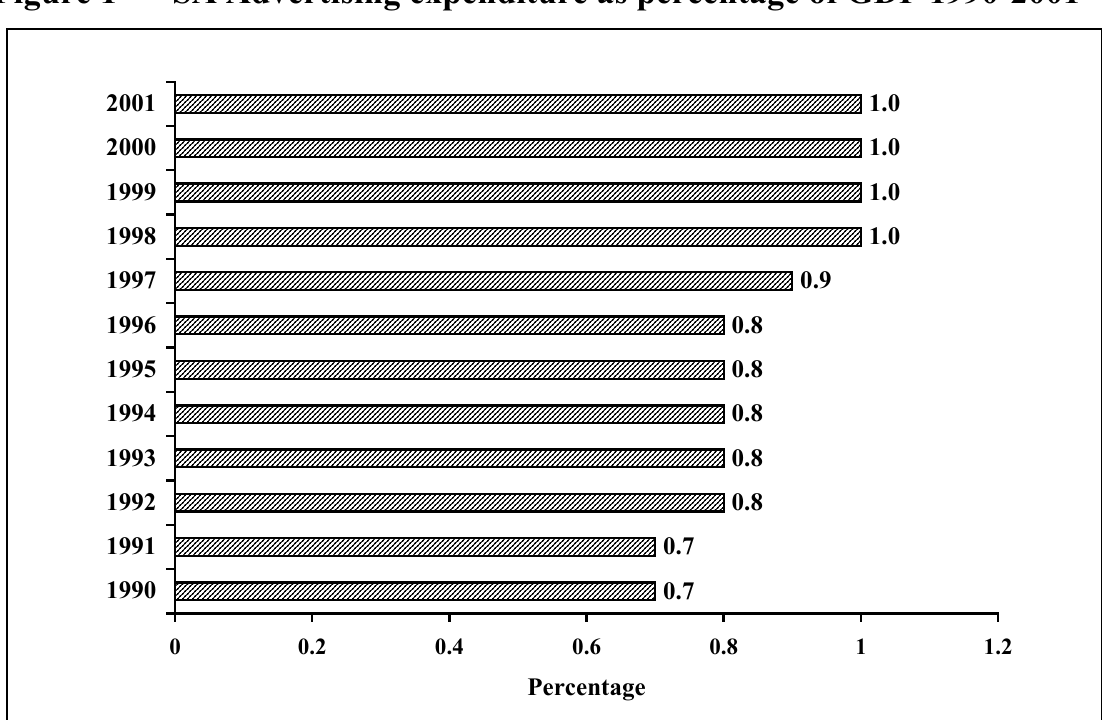
SA Advertising expenditure as percentage of GDP